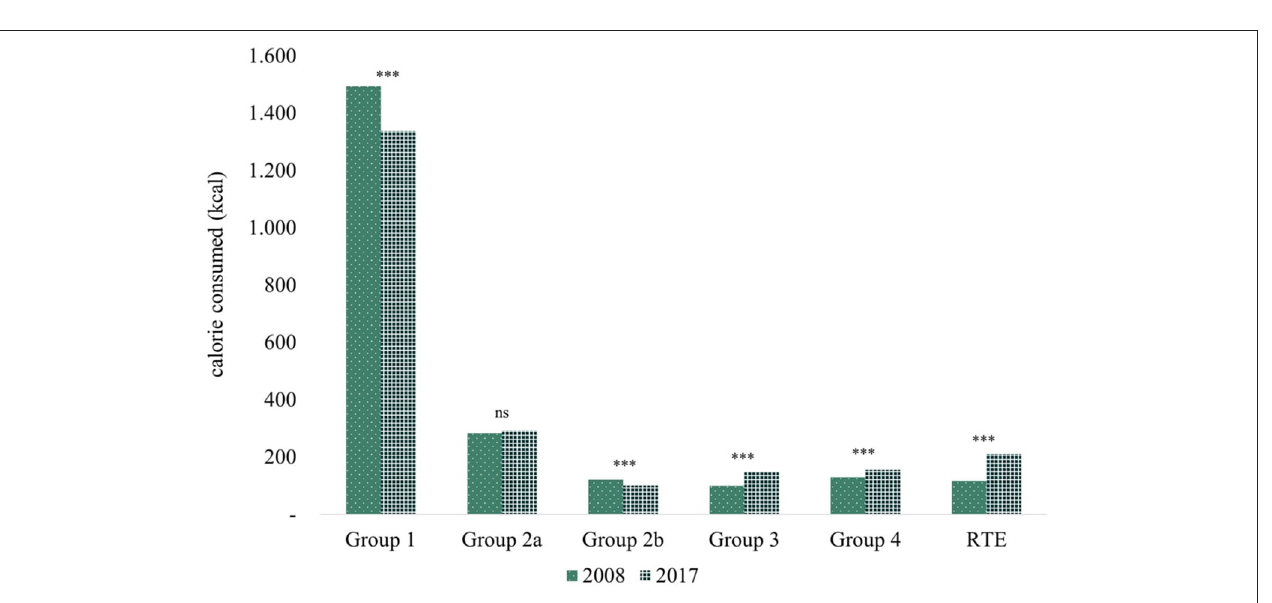
FIGURE 3 | Calorie intake from consumption of food—grouped based on nova food processing classifications in 2008 and 2017 a . a Group 1: Unprocessed or minimally processed foods; Group 2a: Oils and fats; Group 2b: Salt and sugar; Group 3: Processed foods; Group 4: Ultra-processed foods; RTE, Ready-to-eat foods; ns, not significant; ***shows statistical significance at <